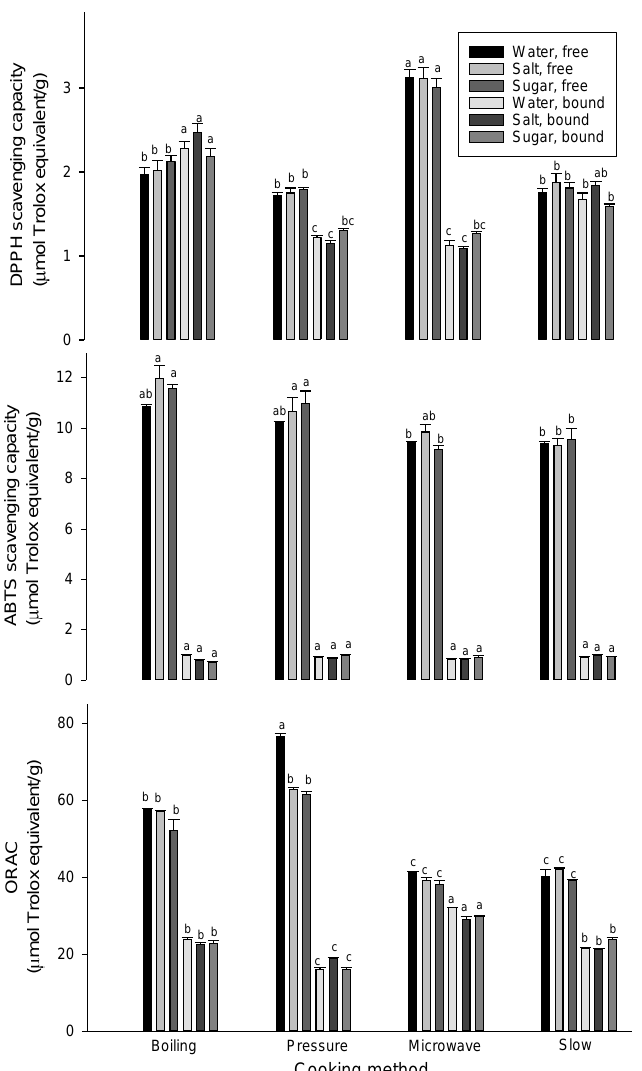
Figure 3. Antioxidant capacities of free and bound phenolic extracts of peas (µmol trolox equivalent/g, db) measured by DPPH (top), ABTS (middle) and ORAC (bottom) assays. For free or bound phenolic extract, means followed by a different letter are significantly different at p < 0.05. Error bars represent standard deviation values ( n = 3).